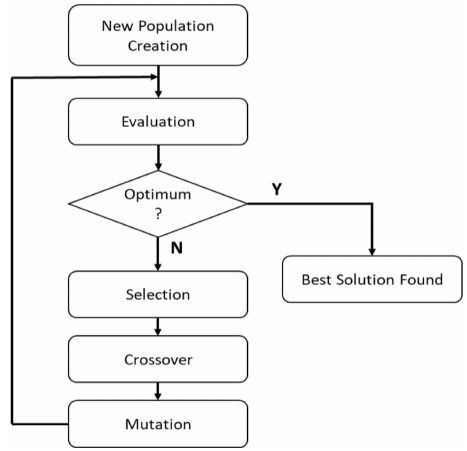
Figure 2. Genetic algorithm process flow.